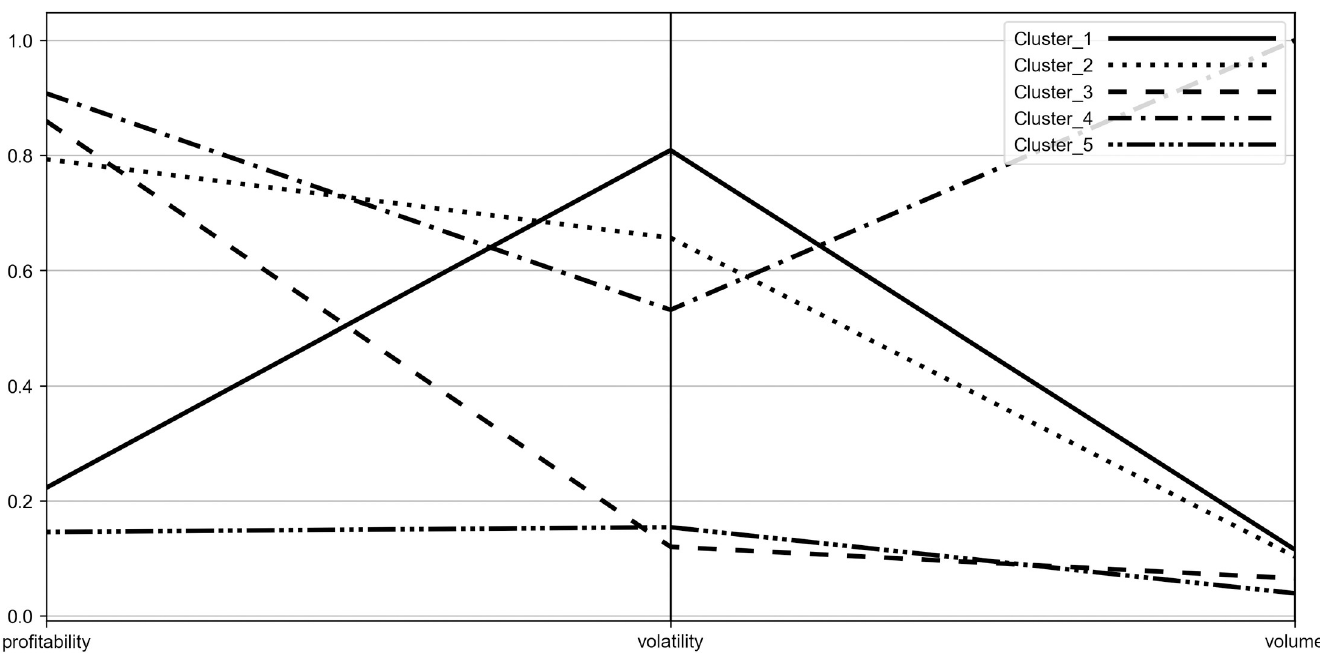
Fig 7. Parallel coordinate plot for centroids–Period_2a.